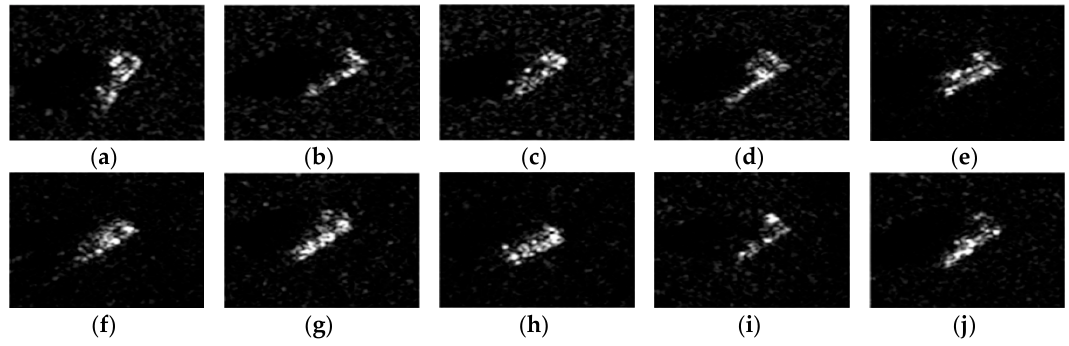
Figure 14. SAR image chips of three targets. ( a ) BMP2; ( b ) BTR70; ( c ) BTR60; ( d ) T72; ( e ) ZSU; ( f ) ZIL; ( g ) T62; ( h ) D7; ( i ) BRDM2; ( j ) 2S1.